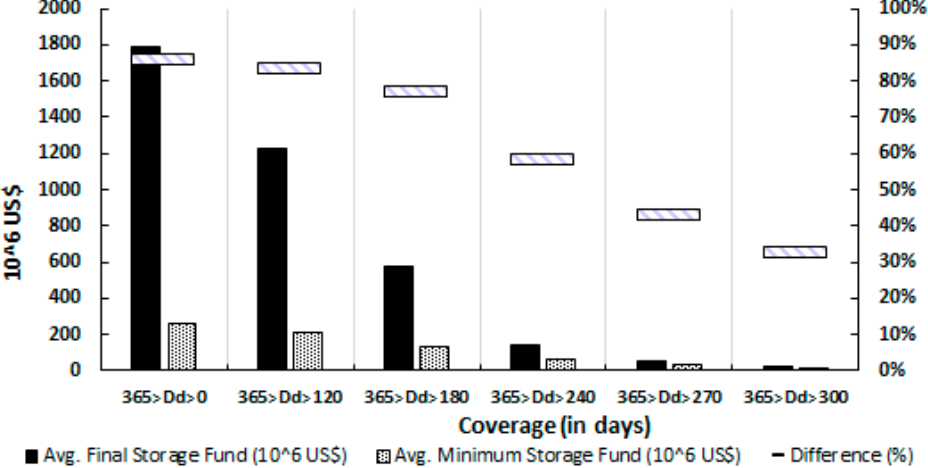
Figure 9. Comparison between final balance stored SA nf (solid bars) and average minimum storage, initially defined as minimum solvency capital (dotted bars).